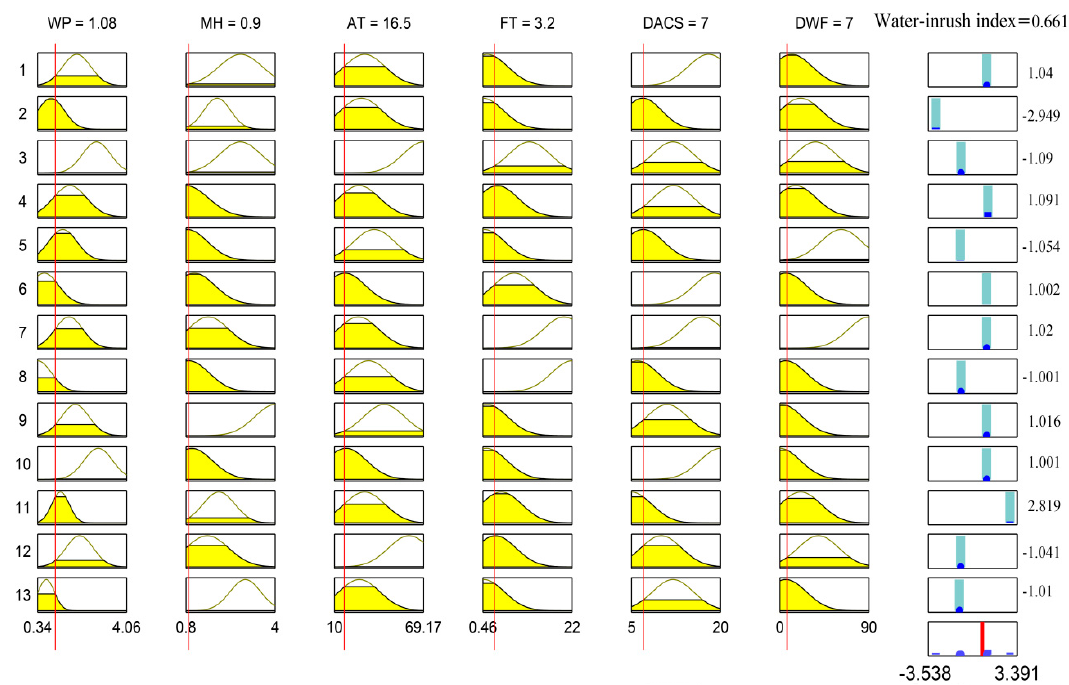
Figure 10. The inferring process of the water inrush index for the 31,503 working face in Huatai coal mine by using the trained rules and trained membership functions.